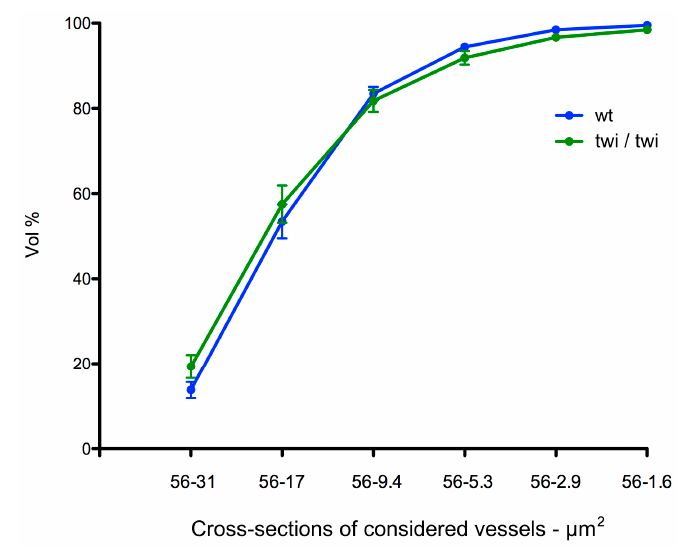
Figure 6. Cumulated contribution of the di ff erent classes of vessels to brain cortex microvascular angioarchitecture. Contribution of the di ff erent cumulated classes of vessels to the total volume occupancy of the reconstituted prefrontal cortex angioarchitectures. Data represent mean +/ − SEM from 11 reconstructed angioarchitectures for both wt (blue) and twitcher (green) mice.